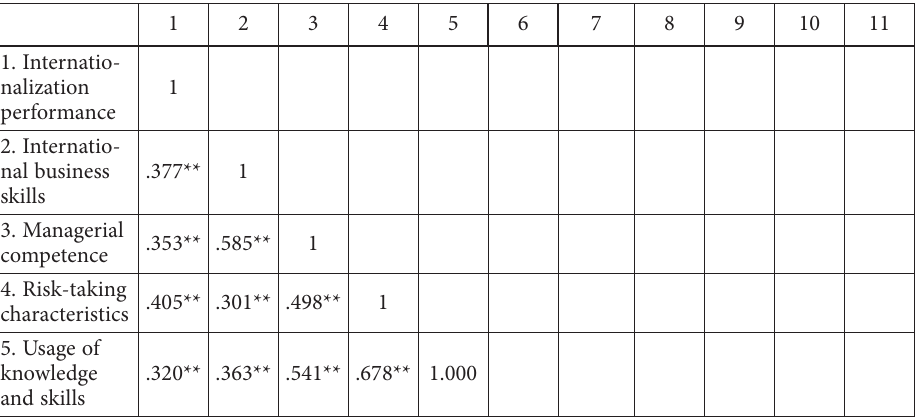
Table 1. Descriptive and correlation data (source: own